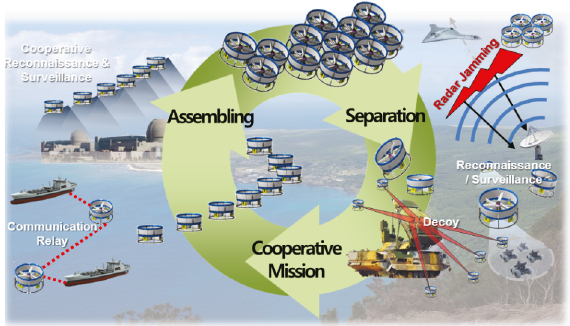
Figure 1: Operational concept of the OFA.